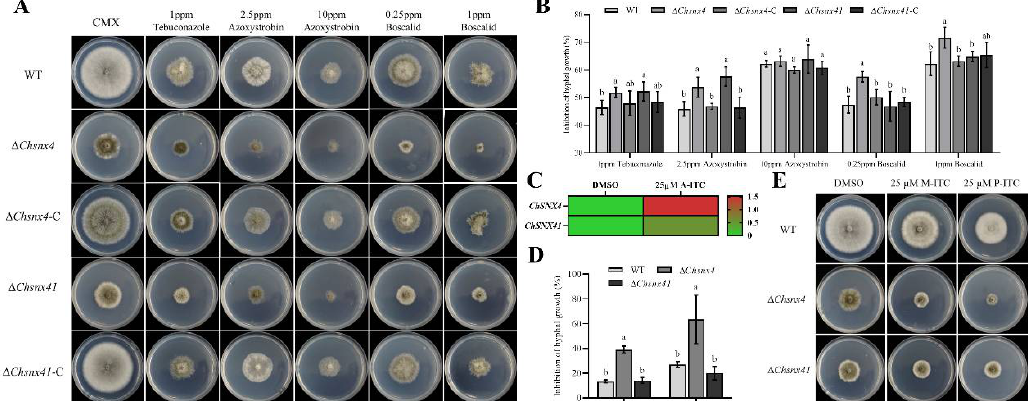
Figure 6. Sensitivity of WT, Δ Chsnx4 , Δ Chsnx4-C , Δ Chsnx41 , and Δ Chsnx41 -C to fungicides and isothiocyanates. ( A ) Colony morphology of the indicated strains grown on CMX supplemented with Tebuconazole, Azoxystrobin, and Boscalid. ( B ) Statistical analysis of the inhibition of the hyphal growth of each strain under Tebuconazole, Azoxystrobin, and Boscalid stress conditions. ( C ) The relative expression levels of ChSNX4 and ChSNX41 under A-ITC treatment. ( D ) Statistical analysis of the inhibition of the hyphal growth of each strain grown on CMX supplemented with M-ITC and P-ITC. ( E ) Colony morphology of the indicated strains grown on CMX supplemented with M-ITC and P-ITC. Each experiment had three replicates and was repeated three times.